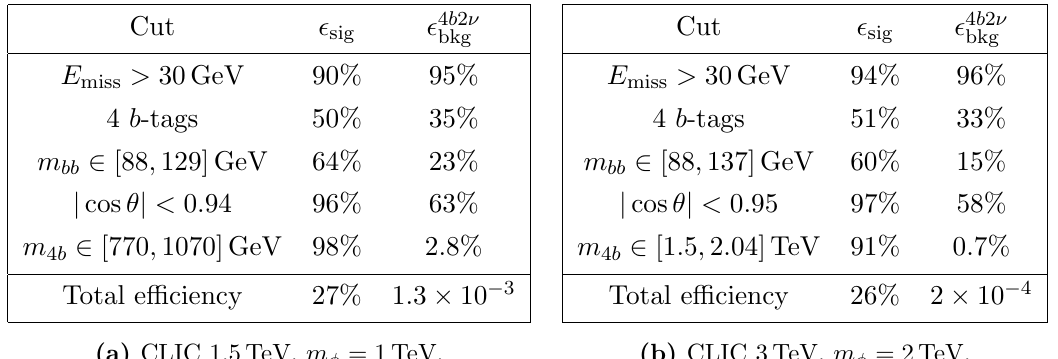
Table 1. E(cid:14)ciencies for signal and background in e + e (cid:0) ! 4 b 2 (cid:23) , for each individual cut applied in the analysis. The two cases m (cid:30) = 1 TeV and m (cid:30) = 2 TeV are shown, respectively, for CLIC Stage II and Stage